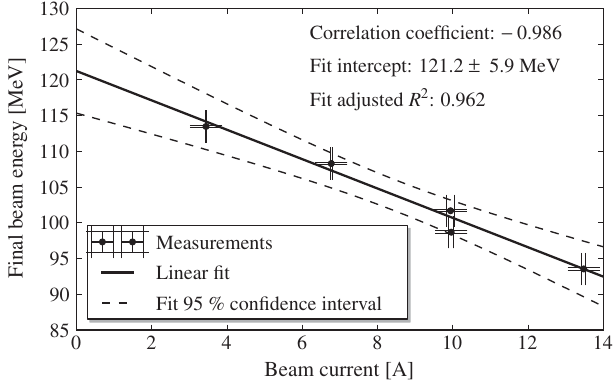
FIG. 9. Measured final energy at different beam currents and levels of deceleration. The intercept derived from a linear fit estimates what the final energy would be without deceleration.